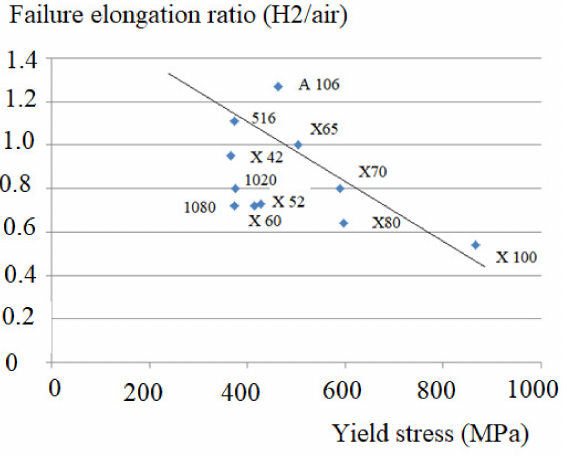
Figure 19. Ratio of failure elongation (H 2 /air) ratio for several pipe steels.